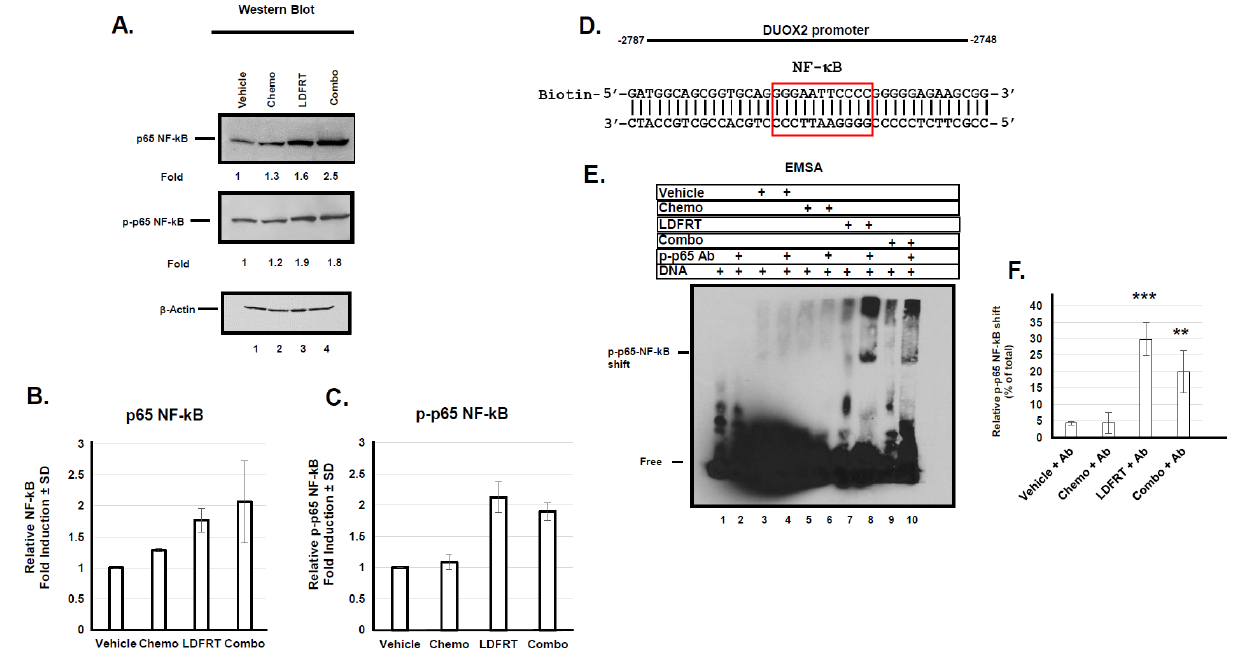
Figure 7. NF- κ B response to mDCF and LDFRT in NCI-N87 cells. ( A ) Western blot analysis of total (p65) and Ser536 phopshorylated (p-p65) NF- κ B. Fold induction of total (p65) and phospho NF- κ B (p-p65) normalized to Actin and untreated (Vehicle) control. ( B , C ) Densitometry quantitation of p65 and phospho p65 Western blots. ( D ) Sequence of NF- κ B binding site in human DUOX2 promoter. ( E ) EMSA of cells exposed to the indicated treatments. Human gastric cancer cells NCI-N87 were exposed to the indicated treatment, nuclear protein extracted, and incubated with the indicated components (+) and run on a native gel. Shifted protein complex is indicated. ( F ) Densitometry quantitation of antibody shifted p-p65 NF- κ B band expressed as a percentage of total biotinylated DNA probe. Data were analyzed by 1 way ANOVA with Dunnett’s multiple comparison test. ** p < 0.005, *** p < 0.0005.